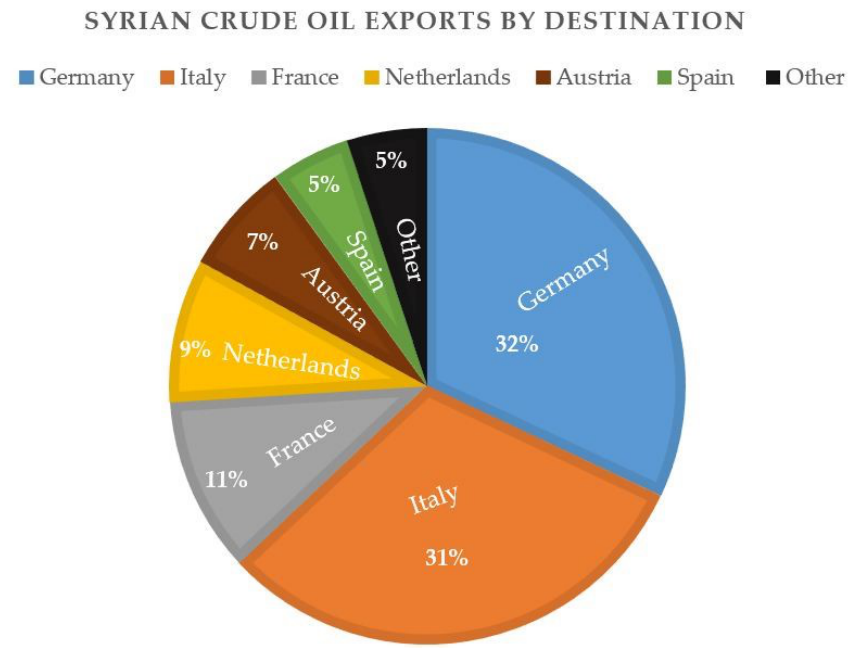
Figure 1. Syria crude oil exports by destination, 2010 [2].